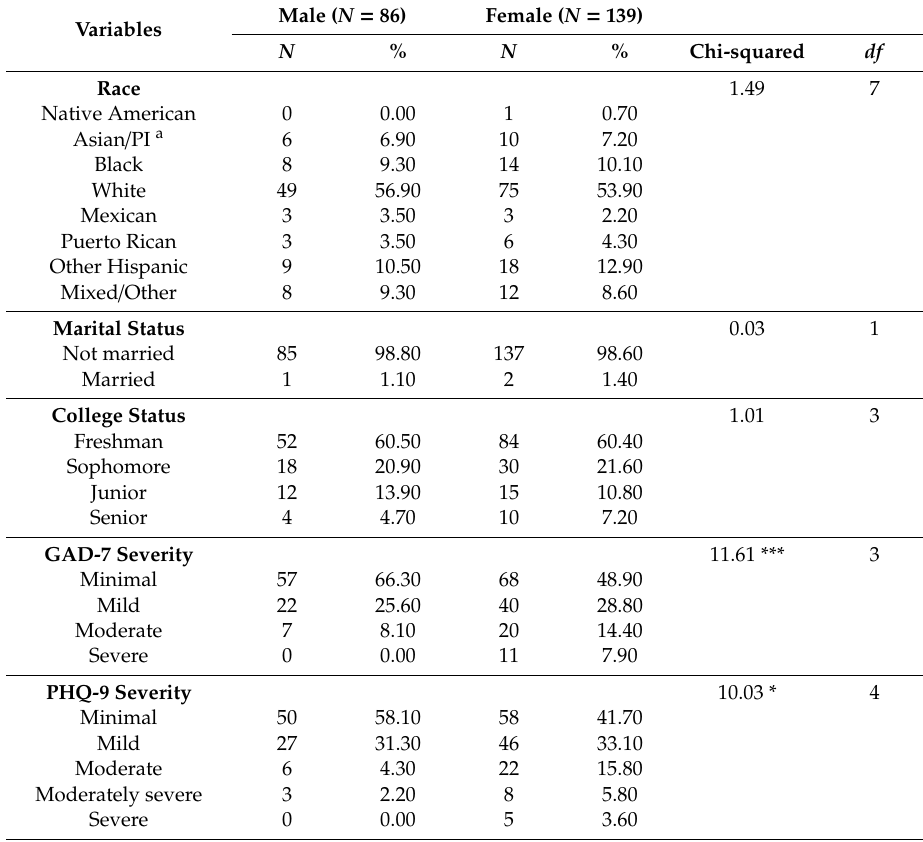
Table 1. Sex di ff erences in participants’ race, marital status, college status, generalized anxiety disorder 7-item scale (GAD-7) severity and patient health questionnaire 9-item scale (PHQ-9) severity.